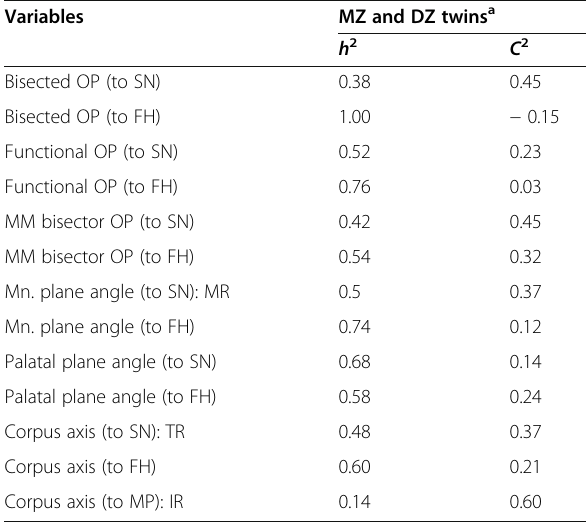
Table 4 Estimates of heritability ( h 2 ) and cultural inheritance ( C 2 ) between MZ and DZ